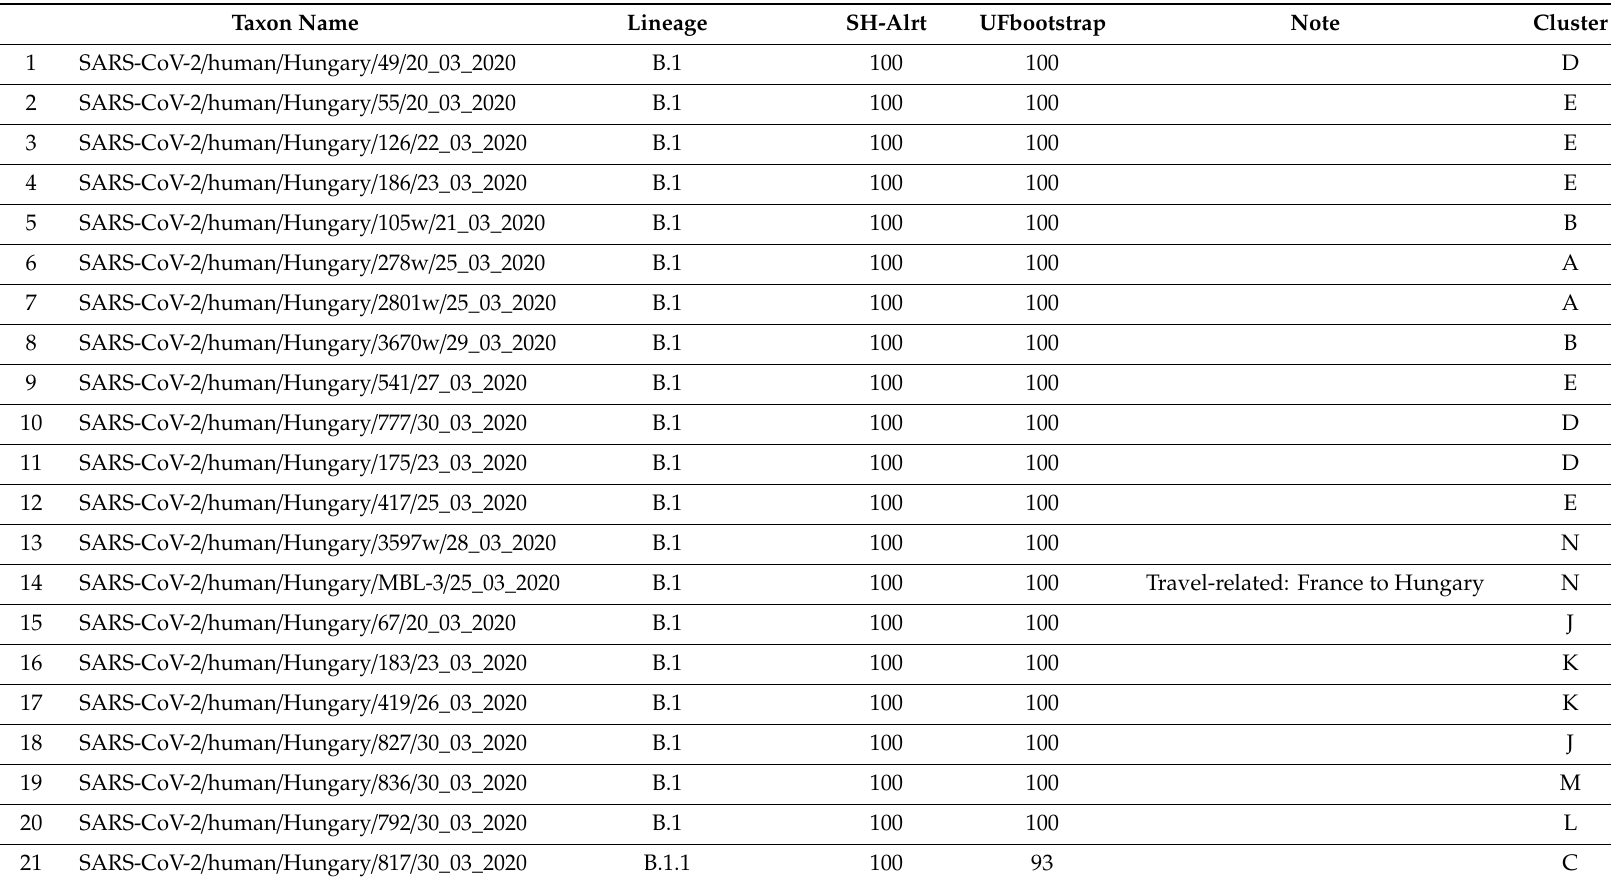
Table 1. Summary of the PANGOLIN software analysis. The table indicates the numbers of Figure 1 and o ff ers additional details for each sample. Background data is also noted where it was available. Letters indicate the Hungarian sequences clusters. Clusters are defined as monophyletic clades with minimum two taxa and at least one Hungarian sequence on Figure